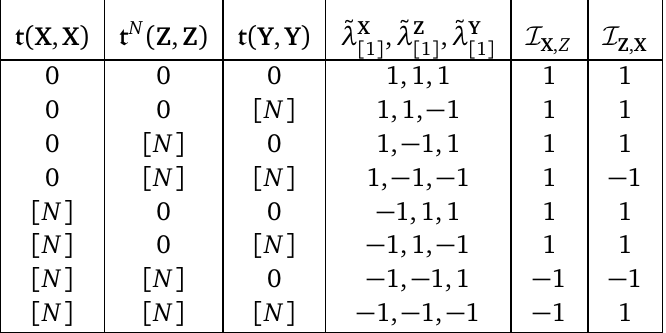
with even N 2 N